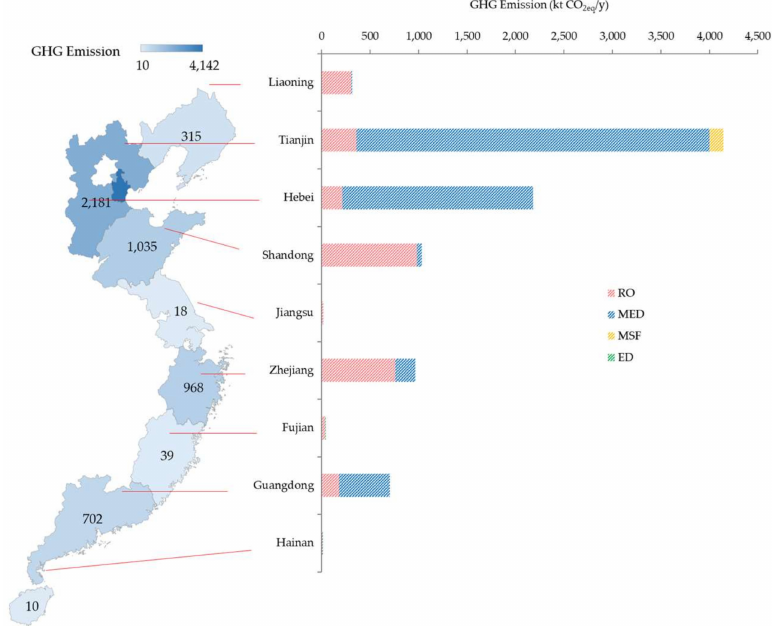
Figure 7. GHG emissions of seawater desalination: Regional distribution and breakdowns by